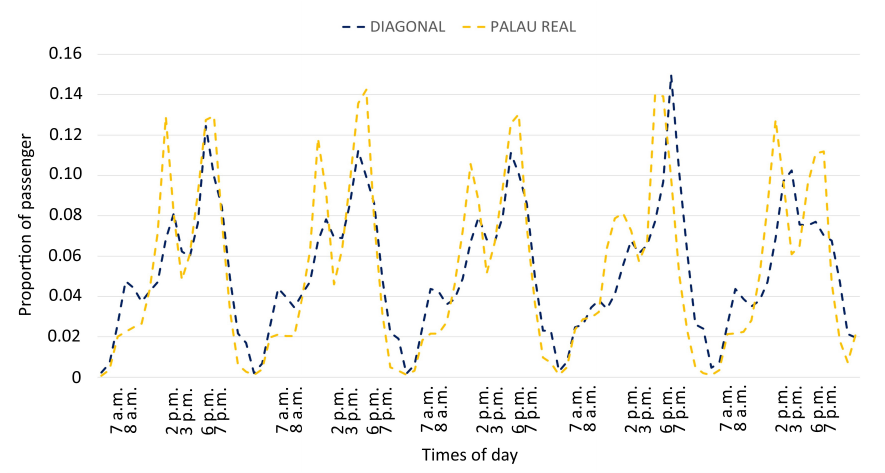
Figure 13. Pattern of boarding in stations at cluster 1 with afternoon rush hour on weekdays.